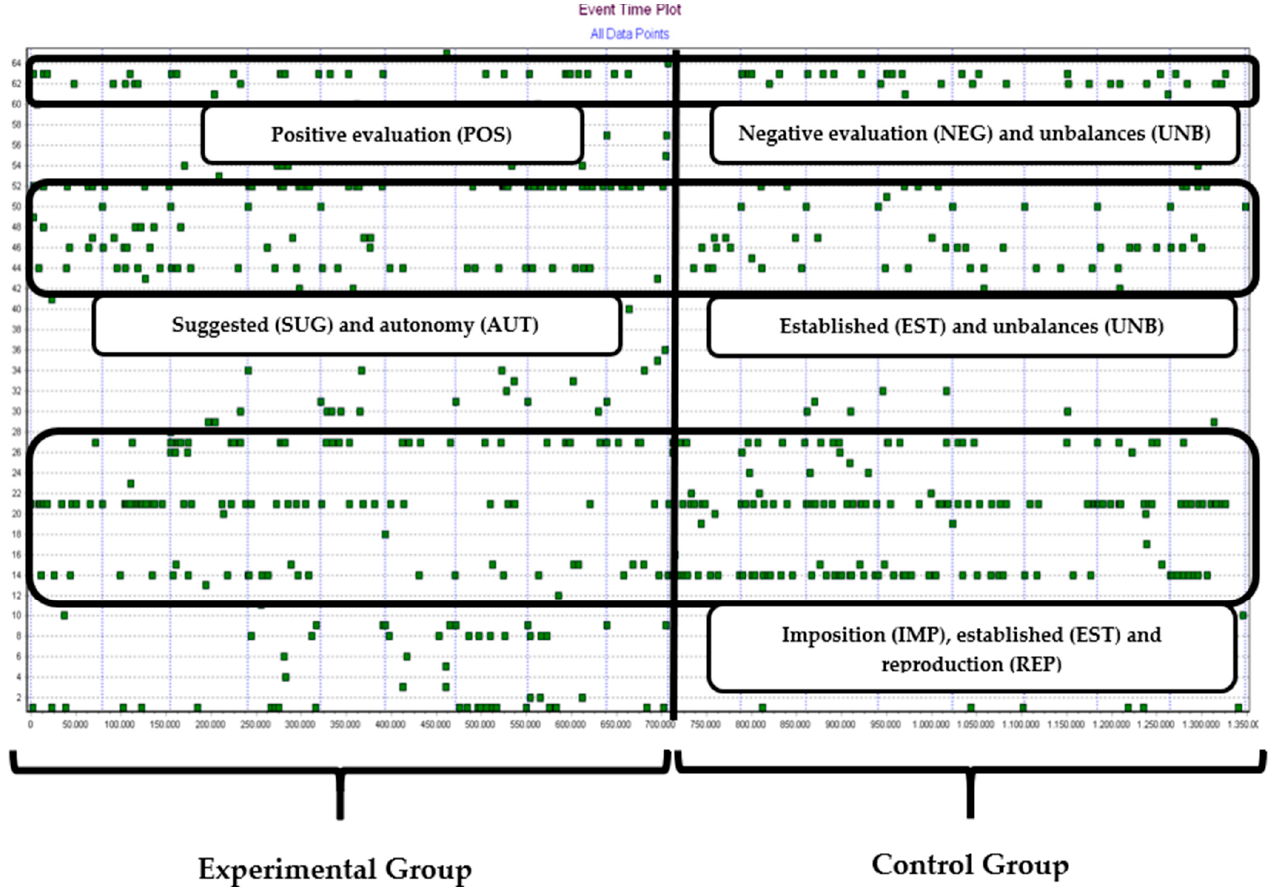
Figure 2. Event Time Plot of EG and CG behaviours throughout the intervention.